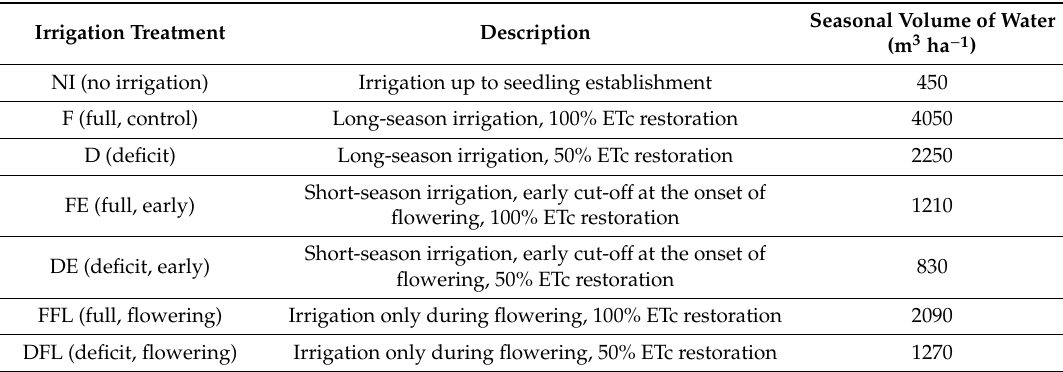
Table 1. Description of the di ff erent irrigation treatments applied to the processing tomato cv. Hypeel F1. ETc: daily